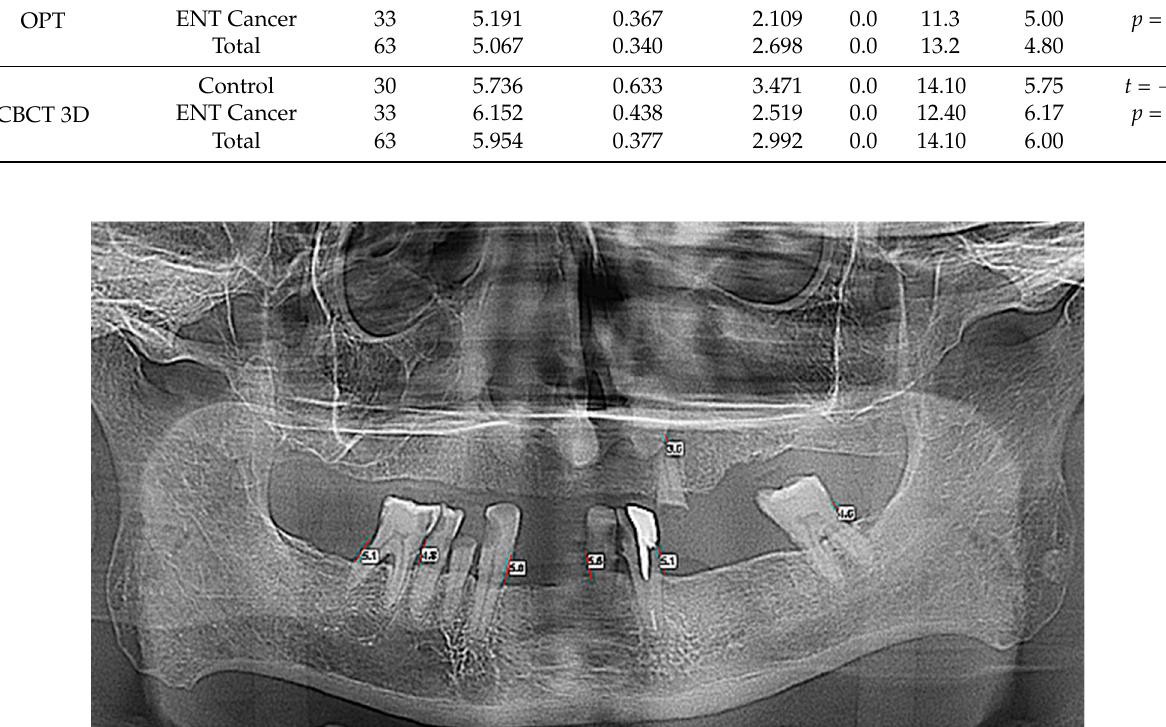
Figure 1. Orthopantomography of patient A.D., larynx cancer, 62 years old, assessment of horizontal bone loss (maximum 5.1 mm at tooth 46) and measurement of the size of periapical lesions present at tooth 23 is 3.6